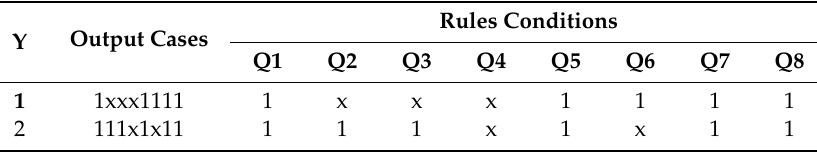
Table 5. Sample Output Values of Main